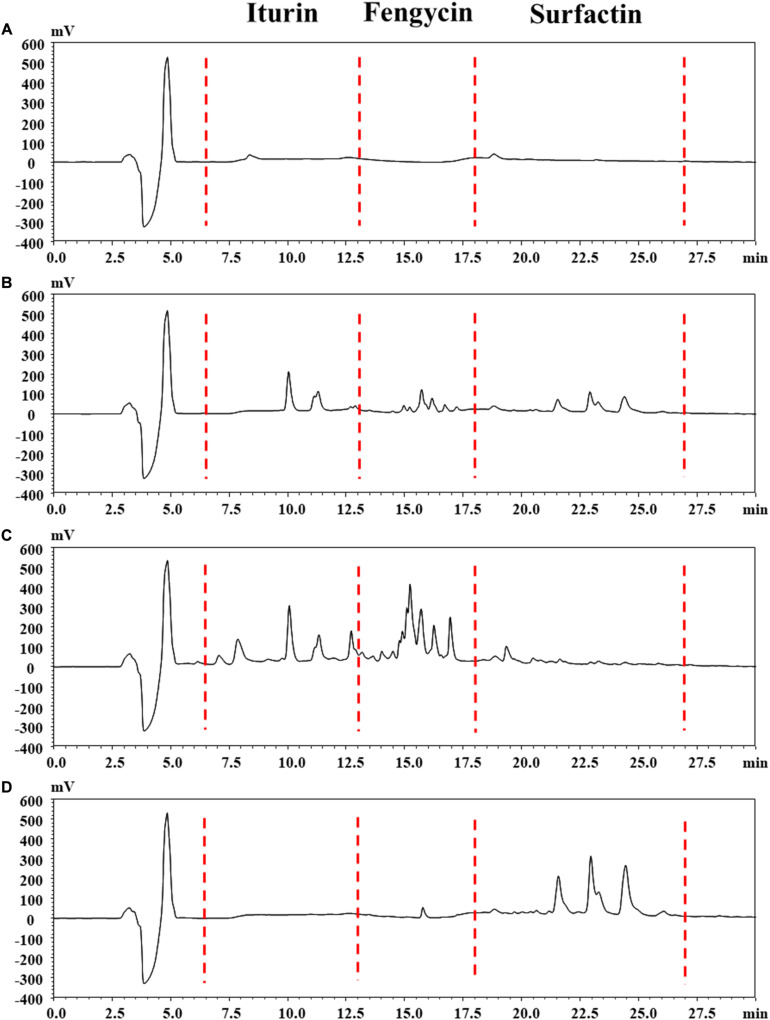
Reversed phase HPLC chromatogram analysis of the lipopeptides mixture Anti-JFL21 and Anti-LQG17. (A) methyl alcohol; (B) complexes with final concentrations of 0.33 mg/mL of commercial standard iturin, fenycin, and surfactin; (C) 1 mg/mL Anti-JFL21 obtained from Bacillus amyloliquefaciens JFL21; (D) 1 mg/mL Anti-LQG17 obtained from Bacillus natto LQG17.